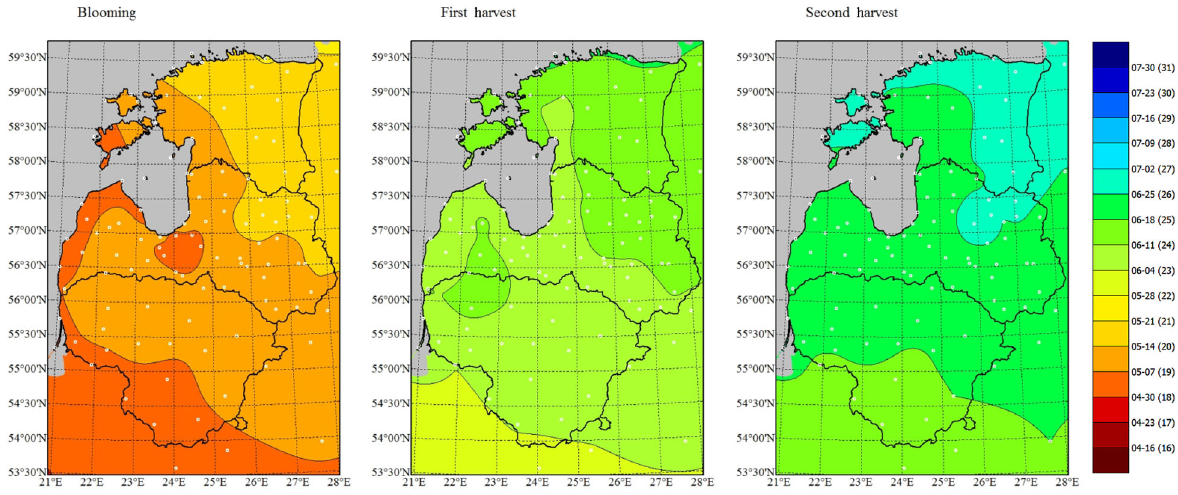
Fig. 6. Timing of strawberry development, weeks of the year, future climate (2070–2099). White dots show the locations of stations used for RCM data bias